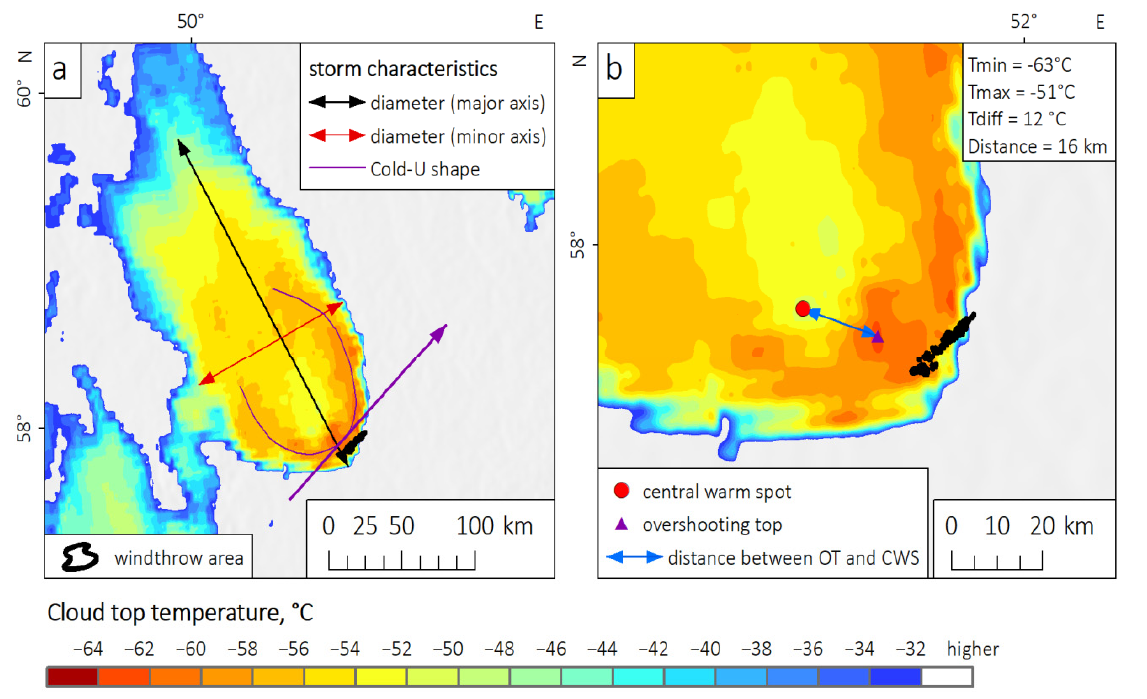
Figure 2. An example of estimation of the characteristics of an isolated supercell storm which caused forest damage (black areas), based on the MSG2 image (IRW 10.8 µm channel, 4 August 2021, 12.00 UTC): ( a )—characteristics of the storm itself, ( b )—characteristics of its cold-U signature. The lifetime of convective storms was estimated based on IRW 10.8 images. According to [55], we considered the time of the beginning of the development of convective cells with brightness temperatures ≤ ‒ 32 °C as the storm start time. For re- generating storms (i.e., a squall line), the lifetime was estimated from the start of the regeneration process. The end of the storm’s lifetime was determined as the time when the dissipation of its spatial structure was clearly identified on a satellite image. If a convective cell causing a linear windstorm or tornado subsequently merged with another storm (e.g., a supercell merged with a quasi-linear system), then the end of the lifetime of each storm was estimated as the end of the lifetime of the merged storm. In the next stage, we identified the signatures on the cloud tops associated with each windthrow event (Figure 4). Signatures of intense updrafts can be detected on multispectral weather satellite imagery both through visual inspection of the contextual information of pixels (i.e., dome-like shape) and with the use of various automated techniques. Thus, in the HRV channel, OTs are easily identified as having a lumpy texture (cauliflower-like appearance) [61]. In the IRW channel, OTs most often appear as isolated regions of cold brightness temperature (BT) relative to the warmer surrounding anvil cloud, which has temperatures at or near that of the tropopause level [62]. OTs are also characterized by a high difference between BT in the 6.5-µm WV channel and IRW channel (about 6–8 K), associated with stratospheric water vapor injection [63]. One of the well- known algorithms of automated OT detection focuses on the identification of small and distinct IRW BT minima within anvil clouds that are colder than the tropopause [64]. Alternative approaches are based on machine learning [65–69]. Automated algorithms are mainly used to compile long-term data series on OTs [7,37,70,71], while other signatures such as cold-U and above-anvil cirrus plumes are often detected manually [69]. It is also